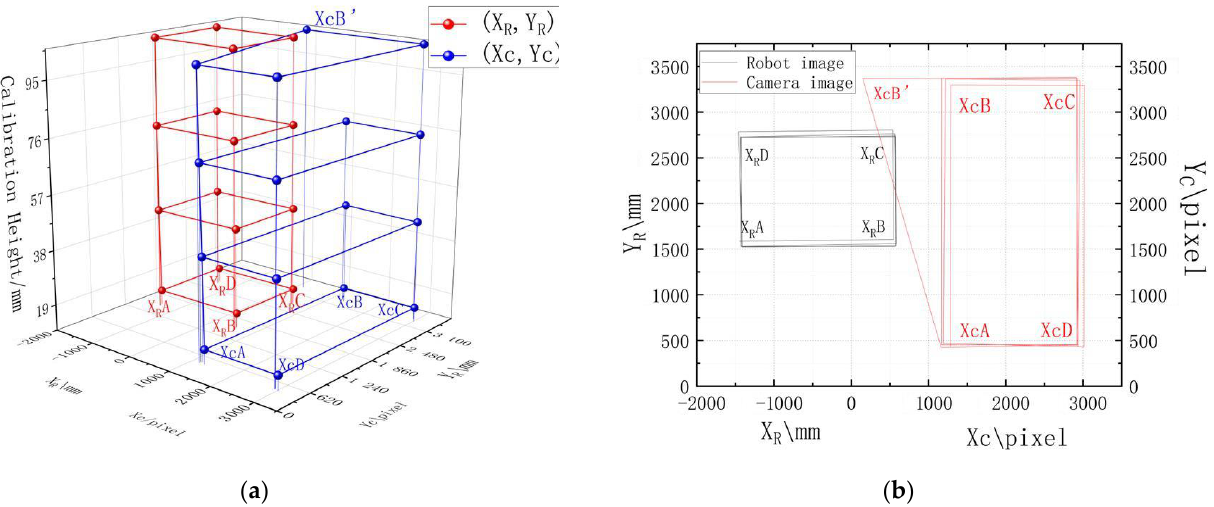
Figure 12. Coordinate analysis diagram: ( a ) three − dimensional display of calibration plate coordi- nates and ( b ) actual camera robot coordinates.